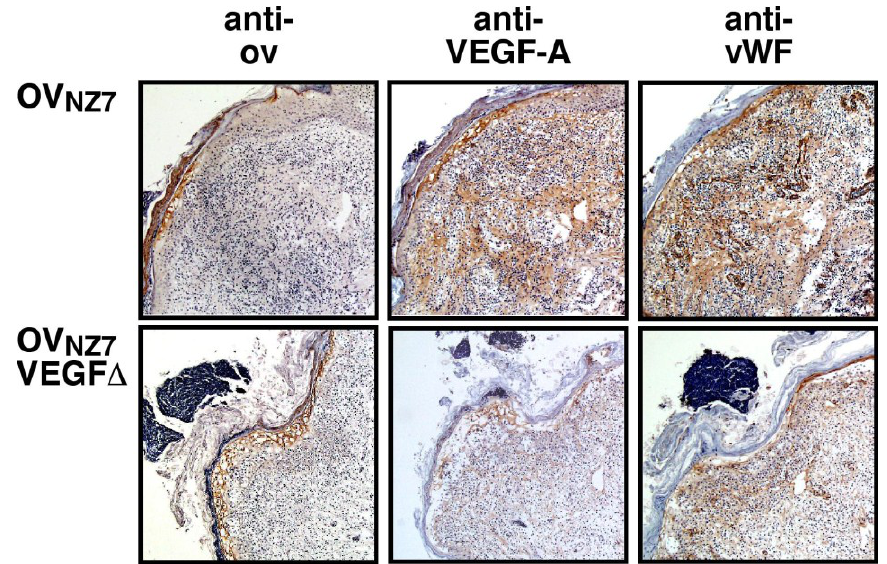
Figure 2 Orf virus (ORFV) vascular endothelial growth factor (VEGF) promotes blood vessel growth in ORFV infected sheep. Scarified skin was inoculated with wt ORFV NZ7 or ORFV-VEGF∆. Shown is immunohistological stained tissue from lesions of wt infected and VEGF∆ infected animals at 6 days post-infection (magnification × 50). The sections were stained with peroxidase conjugated anti-ORFV F1L (major coat envelope protein) antibody (anti-OV), anti-VEGF-A antibody (anti-VEGF-A) and anti-von Willebrand factor antibody (anti-vWF) that stains the endothelial cells of blood vessels. The figure was reproduced from Figure 4 in [173] with permission from Elsevier